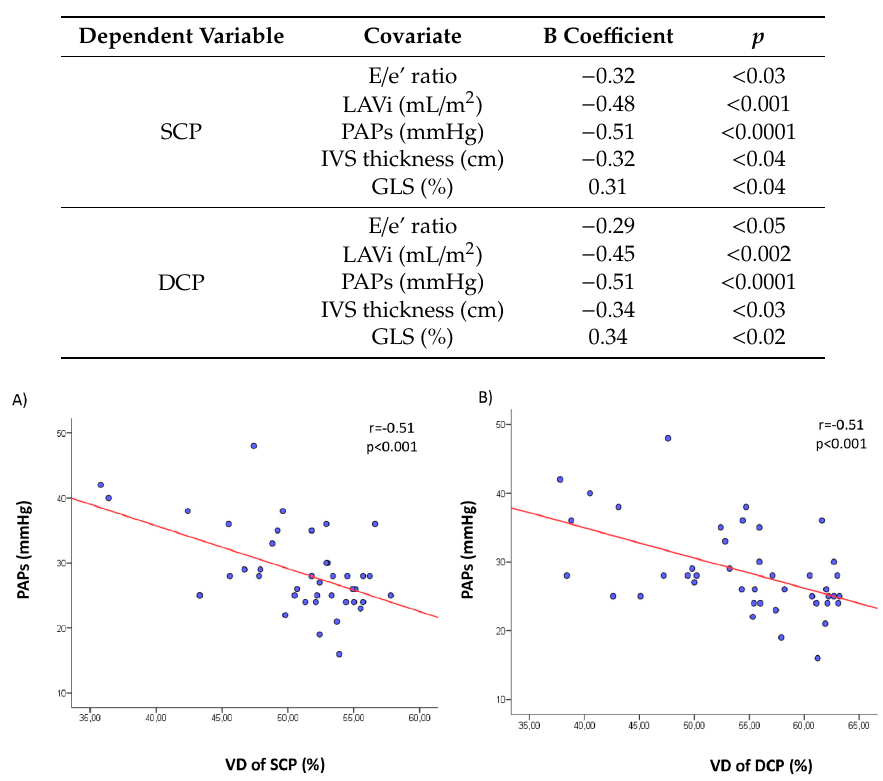
Table 3. Univariate correlation between superficial capillary plexus (SCP) and deep capillary plexus (DCP) in whole image with standard and advanced echocardiographic parameters.